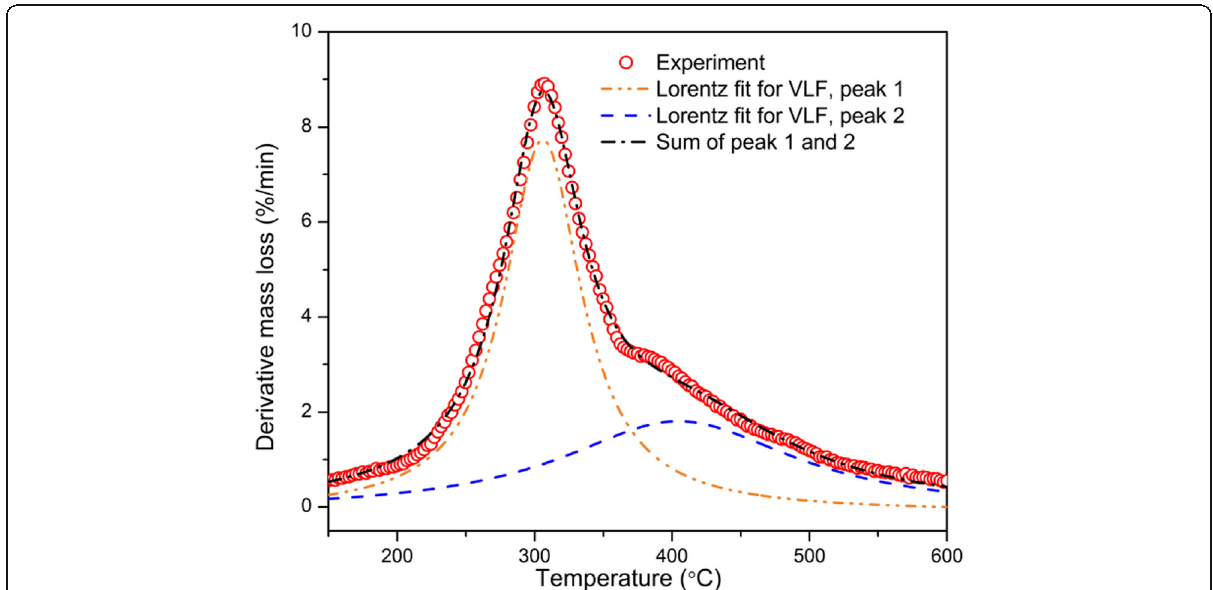
Fig. 3 Deconvolution of the DTG curve at a heating rate of 20 °C min −